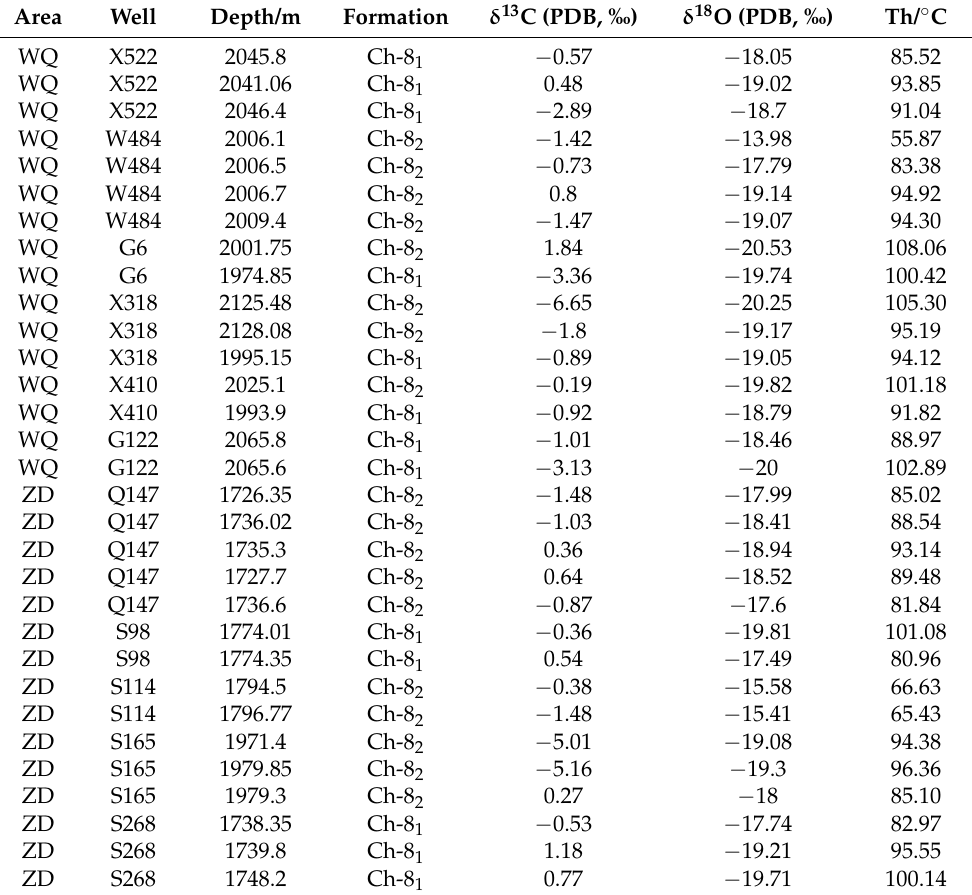
Table 1. Results of the carbon and oxygen isotopes of calcite cements.